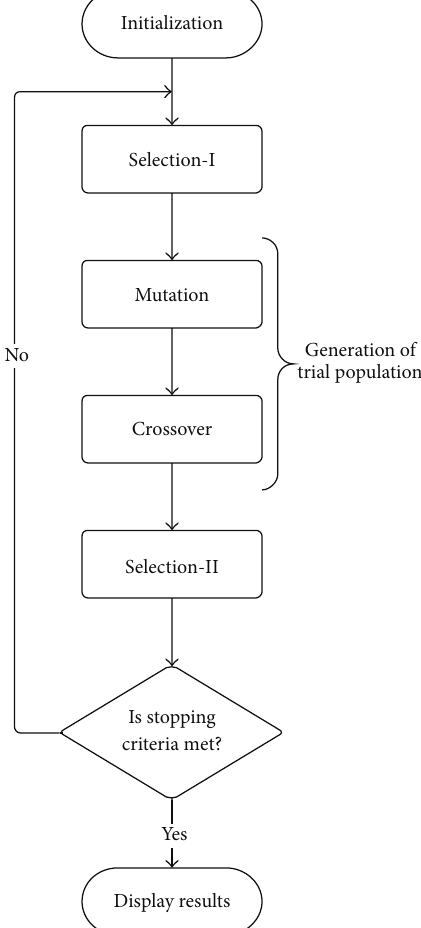
Figure 1: General flow chart of